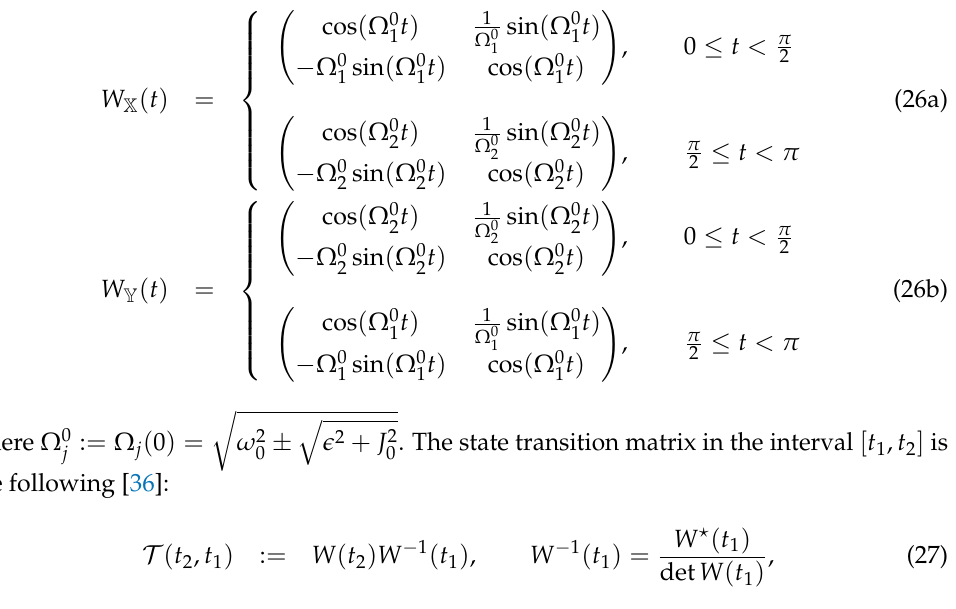
= 1, the points corresponding to bounded 0 = 1. ( b ) Range of parameter points corresponding to 0 ) and for fixed (cid:101) = 0